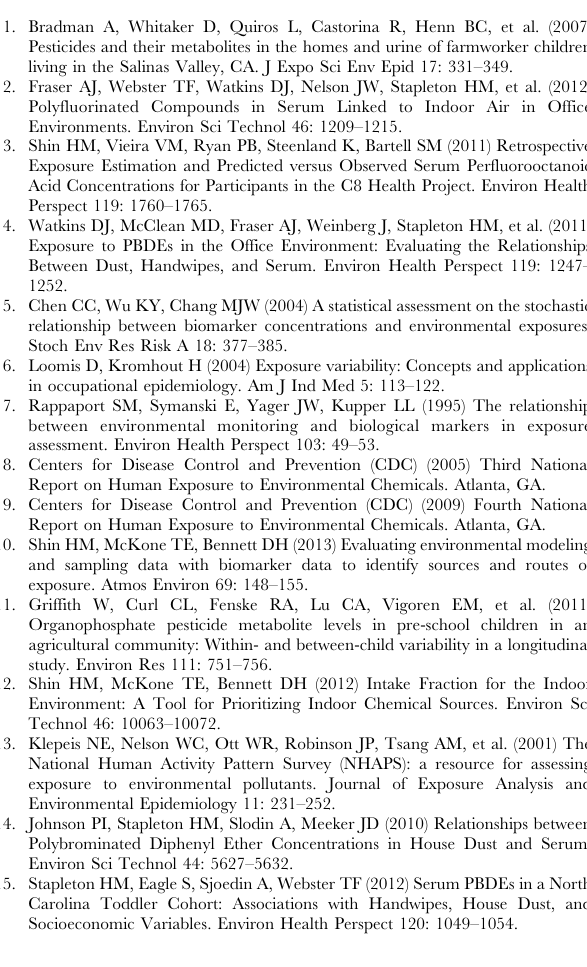
Figure S1 Randomly selected example of auto-correlat- ed wipe concentrations (top) and food exposures (bot- tom) from log-Gaussian random